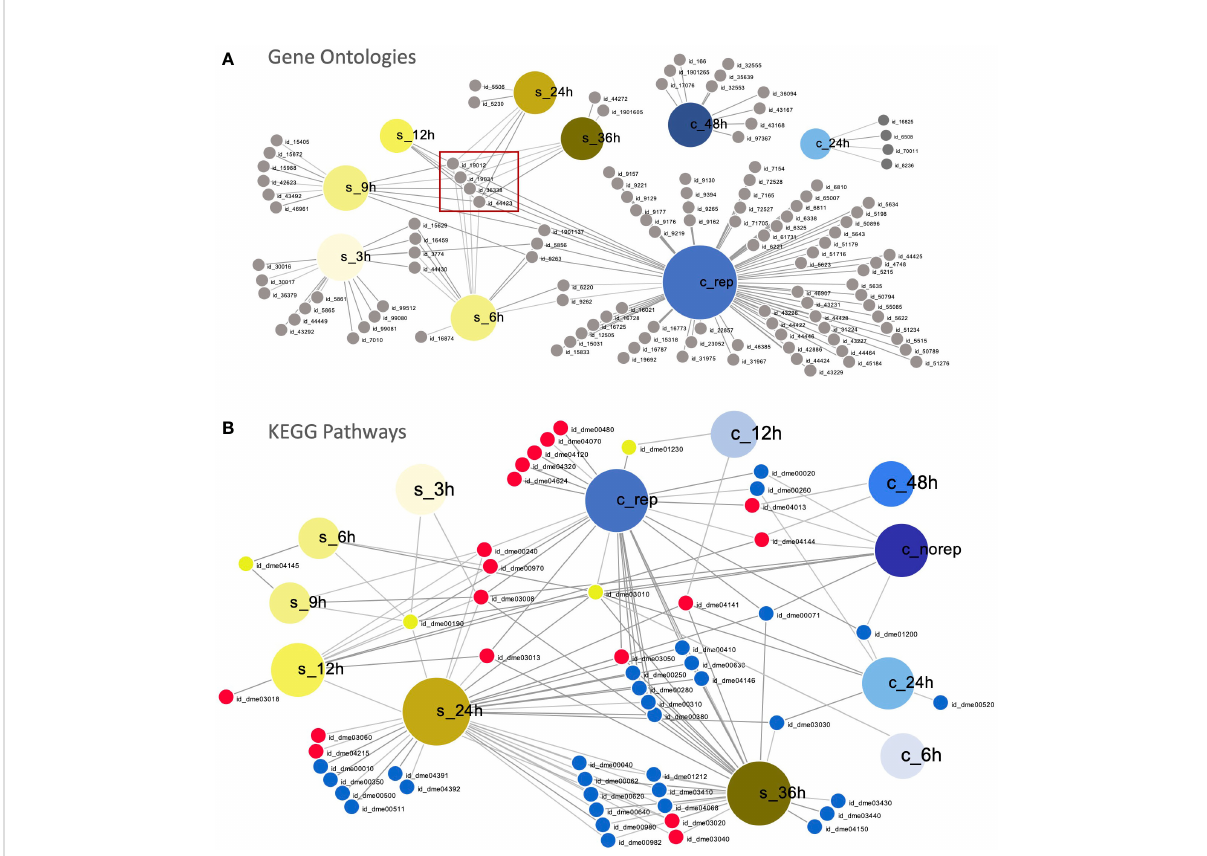
FIGURE 3 Comparison of susceptible and resistant host responses to WSSV infection. (A) Visual representation of overlapping signi fi cantly enriched GO IDs detected in WSSV-injected C. maenas (represented by large blue nodes with ‘ c_ ’ labels) compared to susceptible P. vannamei (represented by large yellow nodes with ‘ s_ ’ labels). Each GO ID is represented by a grey node connected to a large node representing the time point and species within which this term was signi fi cantly enriched. A table of the GO IDs associated with each time point is presented in Supplementary File 10. The central cluster of virus-related GO terms is indicated with a red box. (B) Overlapping KEGG pathways in WSSV-injected P. vannamei (represented by large yellow nodes with ‘ s_ ’ labels) and C. maenas (represented by large blue nodes with ‘ c_ ’ labels). Each KEGG ID is represented by a small node connected to a large node representing the time point and species within which this pathway was signi fi cantly enriched. Down-regulated KEGGs are depicted by small blue nodes, down-regulated KEGGs are represented by small red nodes and shared KEGGs that were both up- and down-regulated are depicted by yellow nodes. A table of the KEGG pathway IDs associated with each time point is presented in Supplementary File 11. These plots were created using DiVenn